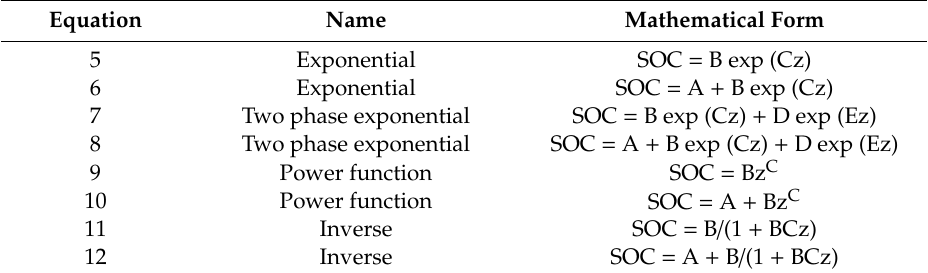
Table 1. Predictive depth functions applied to the soil organic profiles from New South Wales. Equation numbers relate to descriptions in the